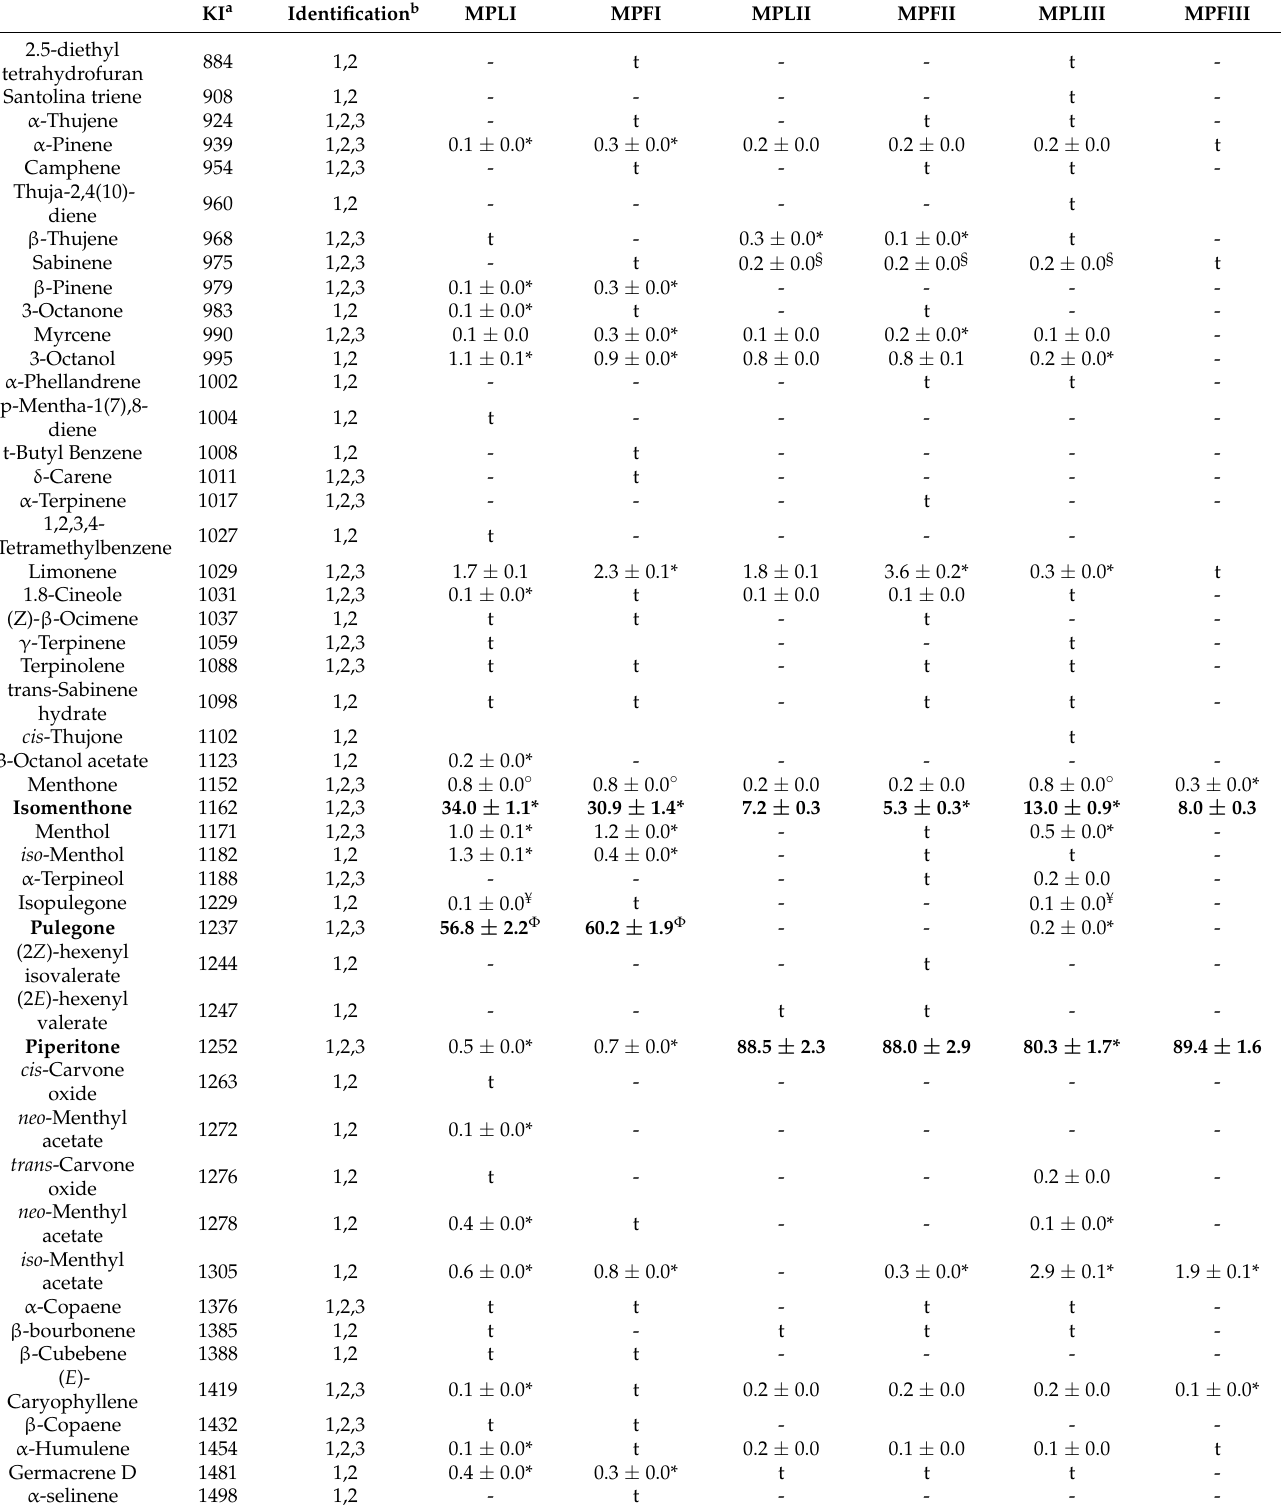
Table 2. Chemical composition of Mentha pulegium EOs collected in three different Sicilian locations (I, II, and III; see Section 3.2 for more details; L= leaf; F=flower). Bold values refer to the most abundant compounds identified. Results are expressed as mean area percentage (%) ± standard deviation (S.D.) of three independent determinations in triplicate ( n =